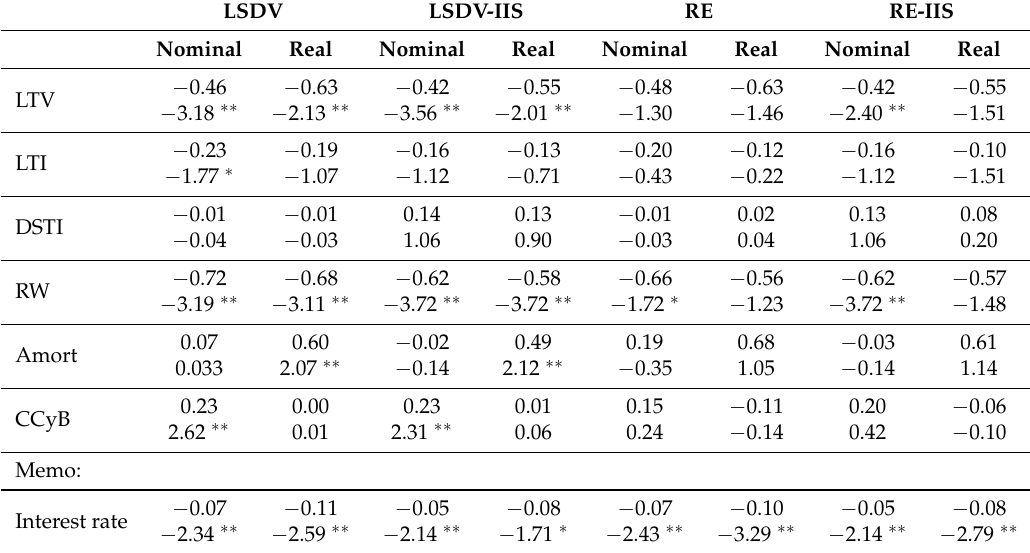
Table 7. Estimated impact coefficients on nominal and real credit growth. Estimated (LSDV, LSDV-ISS, RE, and RE-IIS) effects for LTV, LTI, DSTI, RW, Amort and CCyB. Results for the central bank